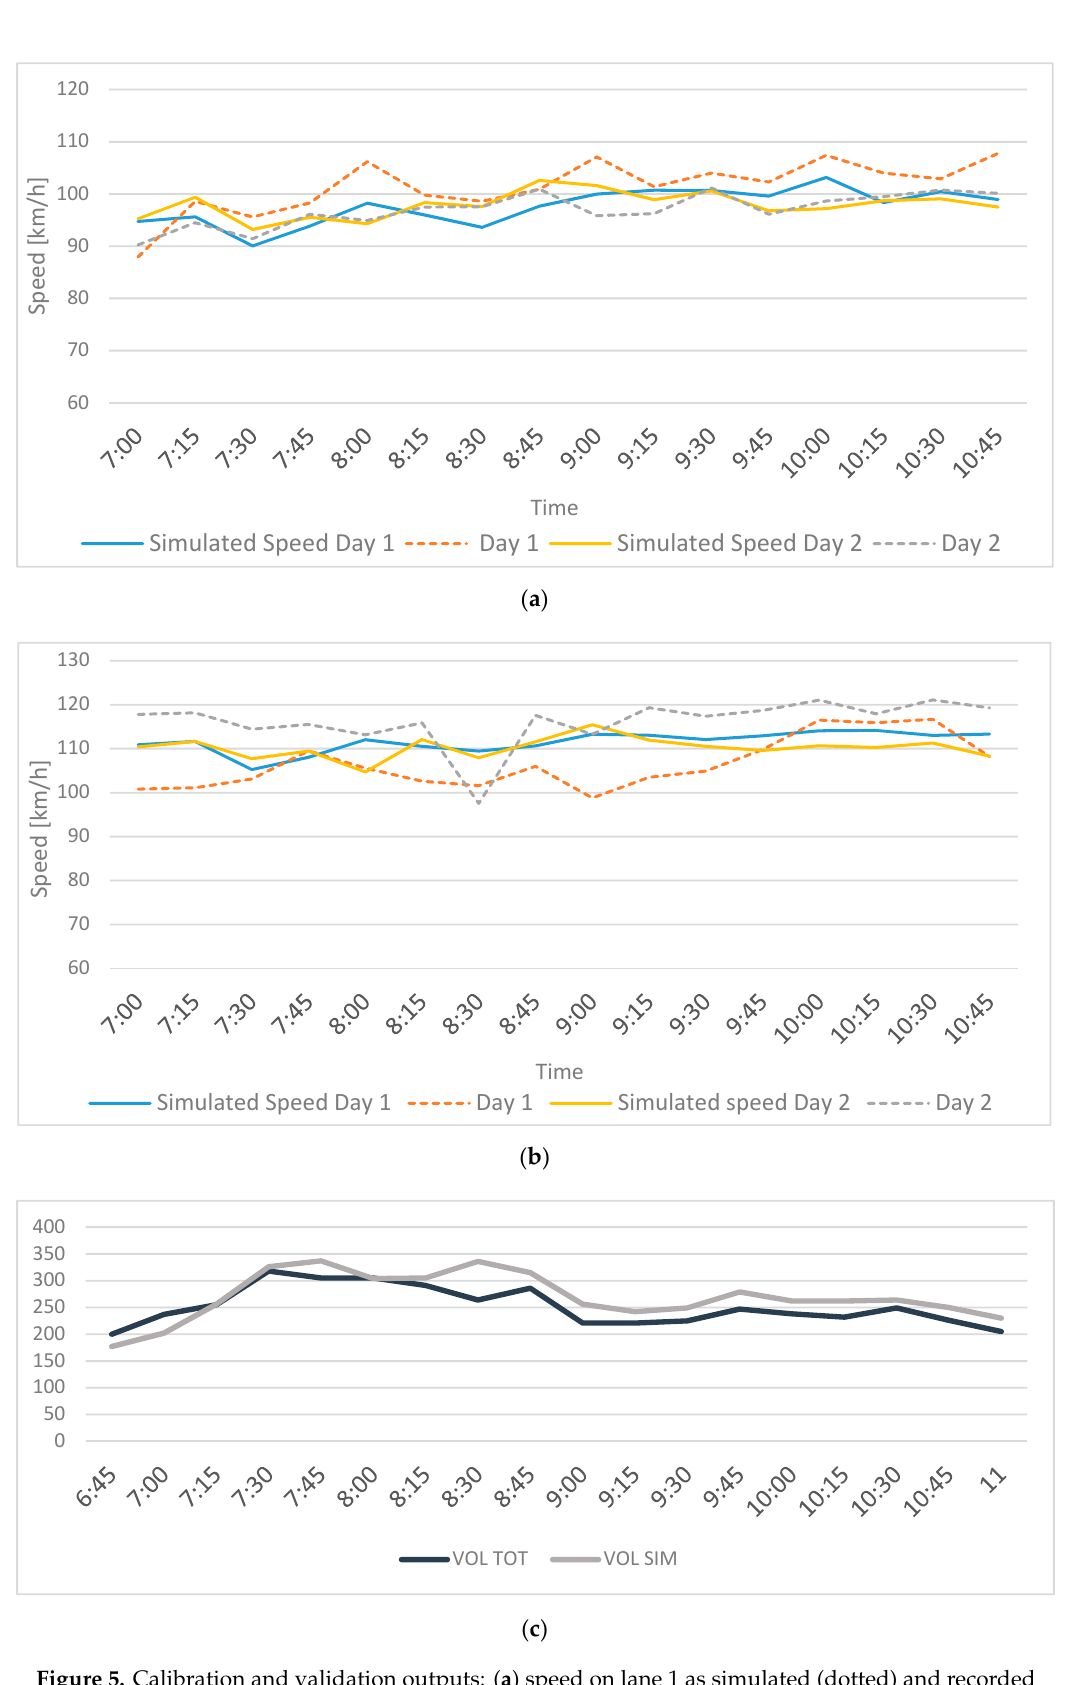
Figure 5. Calibration and validation outputs: ( a ) speed on lane 1 as simulated (dotted) and recorded (continuous), ( b ) speed on lane 2 as simulated (dotted) and recorded (continuous) and ( c ) tra ffi c